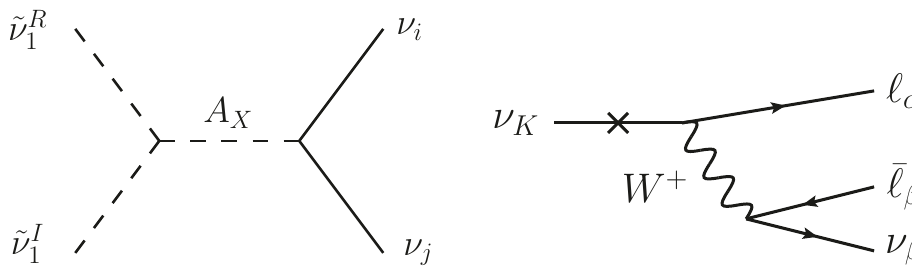
Figure 8 . (Left) Annihilation channel for DM into a pair of neutrinos, where i; j runs from 1 to 5. When i = 1{3 and j = K = 4 ; 5 corresponds to annihilation into one active and one heavy neutrinos. (Right) The dominant decay of the heavy neutrino into an active neutrino and charged leptons. Here K is 4 or